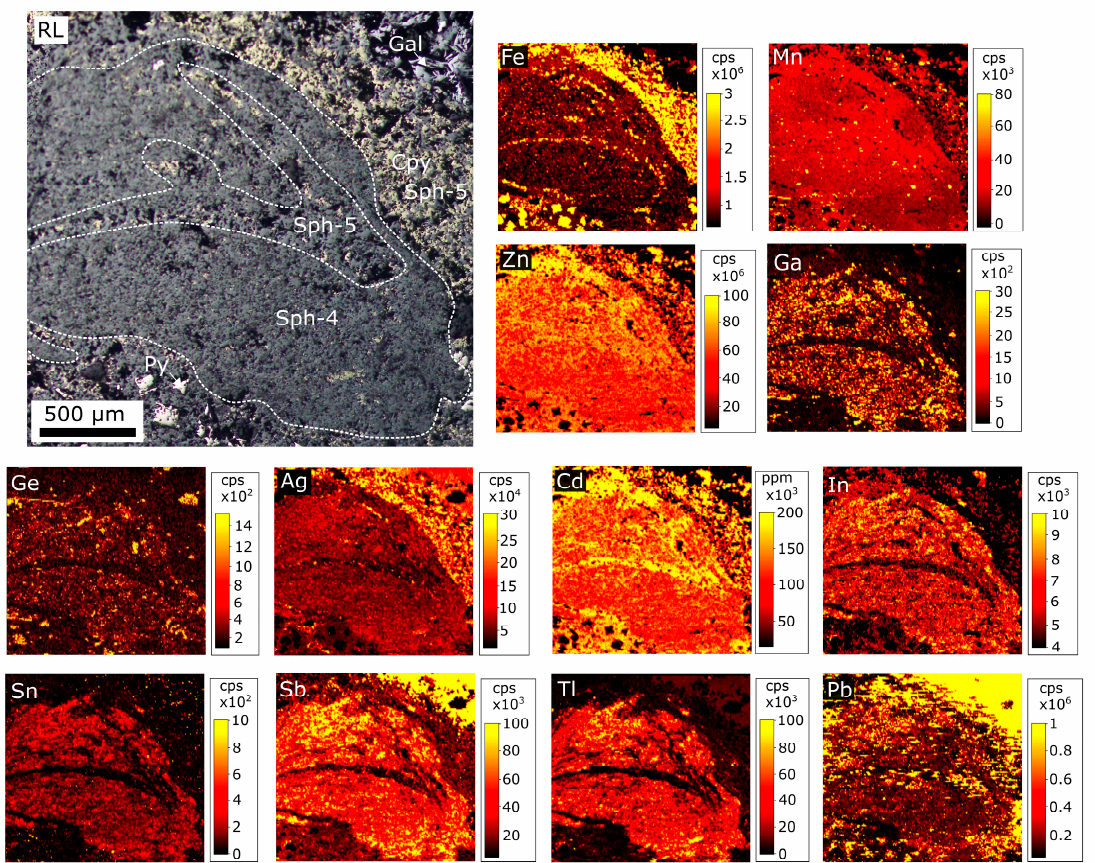
Figure 8. LA-ICP-MS trace element maps across a sample containing sph-4 and recrystallised sph-5. These maps show that sph-5 is depleted in Ge, Ga, In, Sn, Sb, Ag and Tl, and enriched in Cd and Pb relative to sph-4. Some contact zones between sph-4 and sph-5 are enriched in Tl and In. All trace element maps are in counts per second (cps).